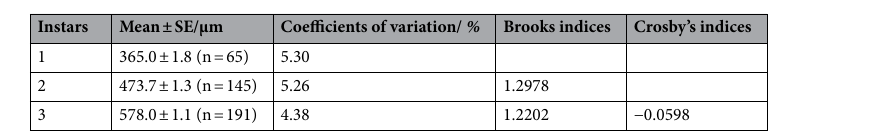
Table 1. Average values, coefficients of variation, Brooks indices, and Crosby’s indices of the head capsule widths (HCWs) from three larval instars of Rhynchaenus maculosus